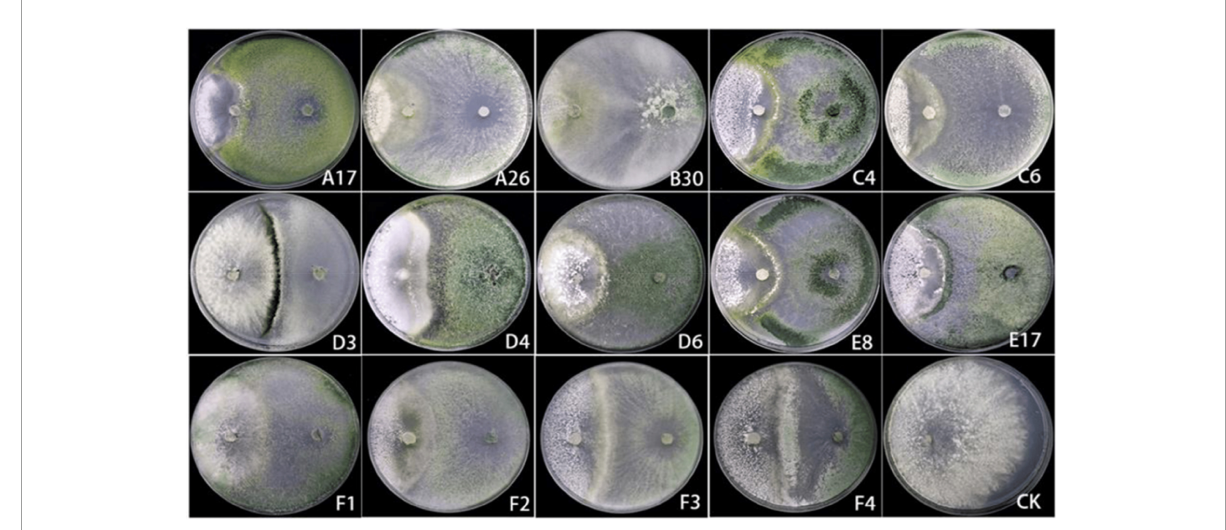
FIGURE3 The confrontation effect of Trichoderma strains against Sclerotinia asari